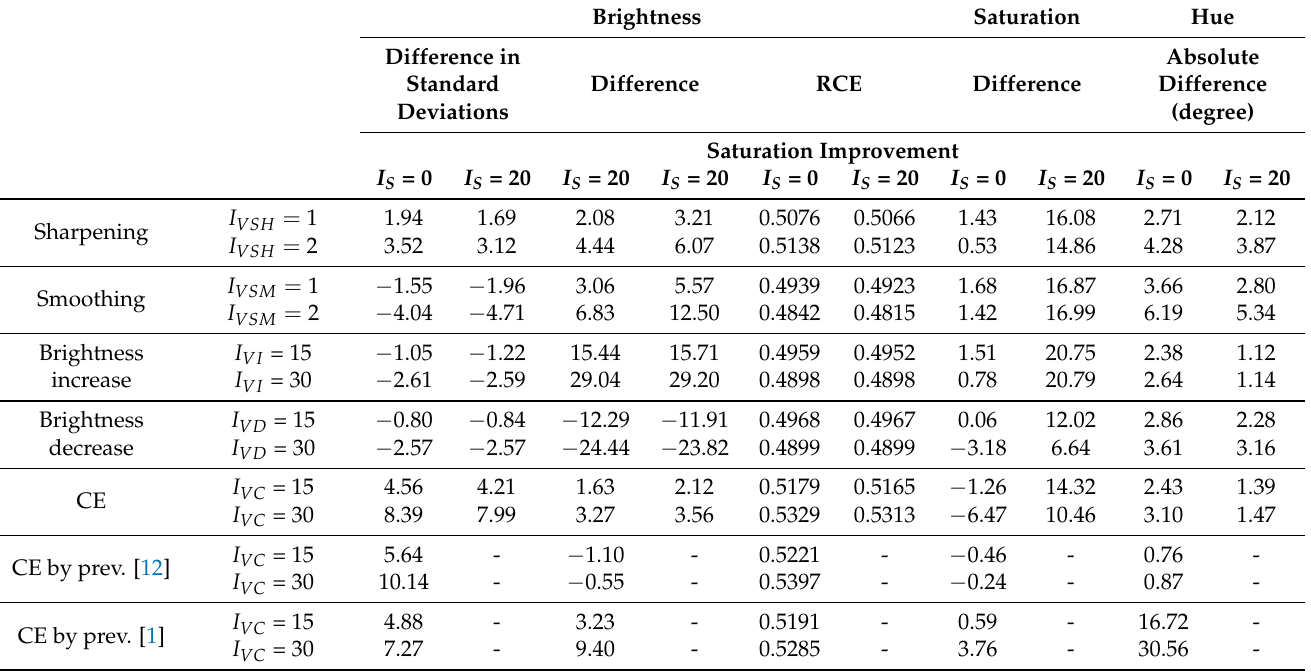
Table 2. Evaluations of brightness control, saturation improvement, and hue